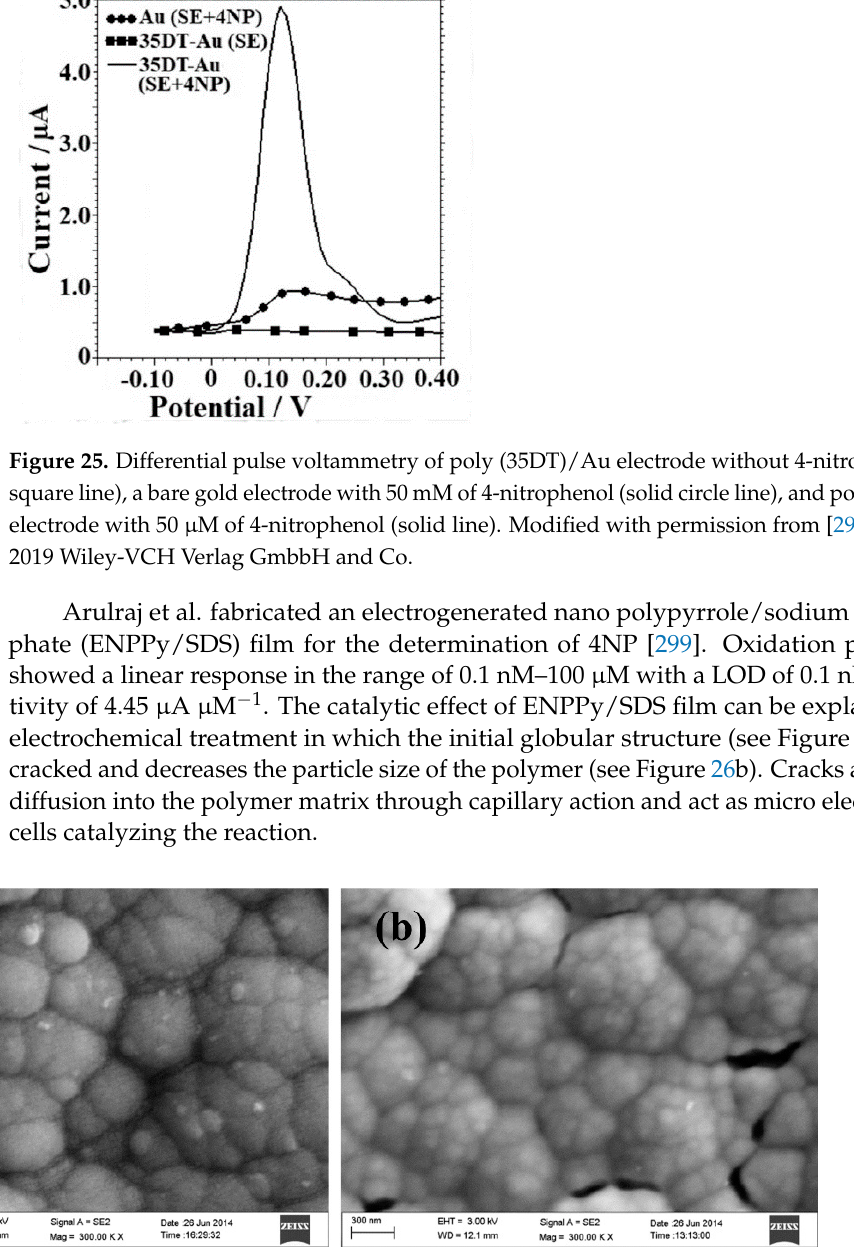
Figure 26. FESEM images of polypyrrole/sodium dodecyl sulphate film, ( a ) before and ( b ) after electrochemical treatment. Modified with permission from [299]. Copyright 2015 Elsevier.